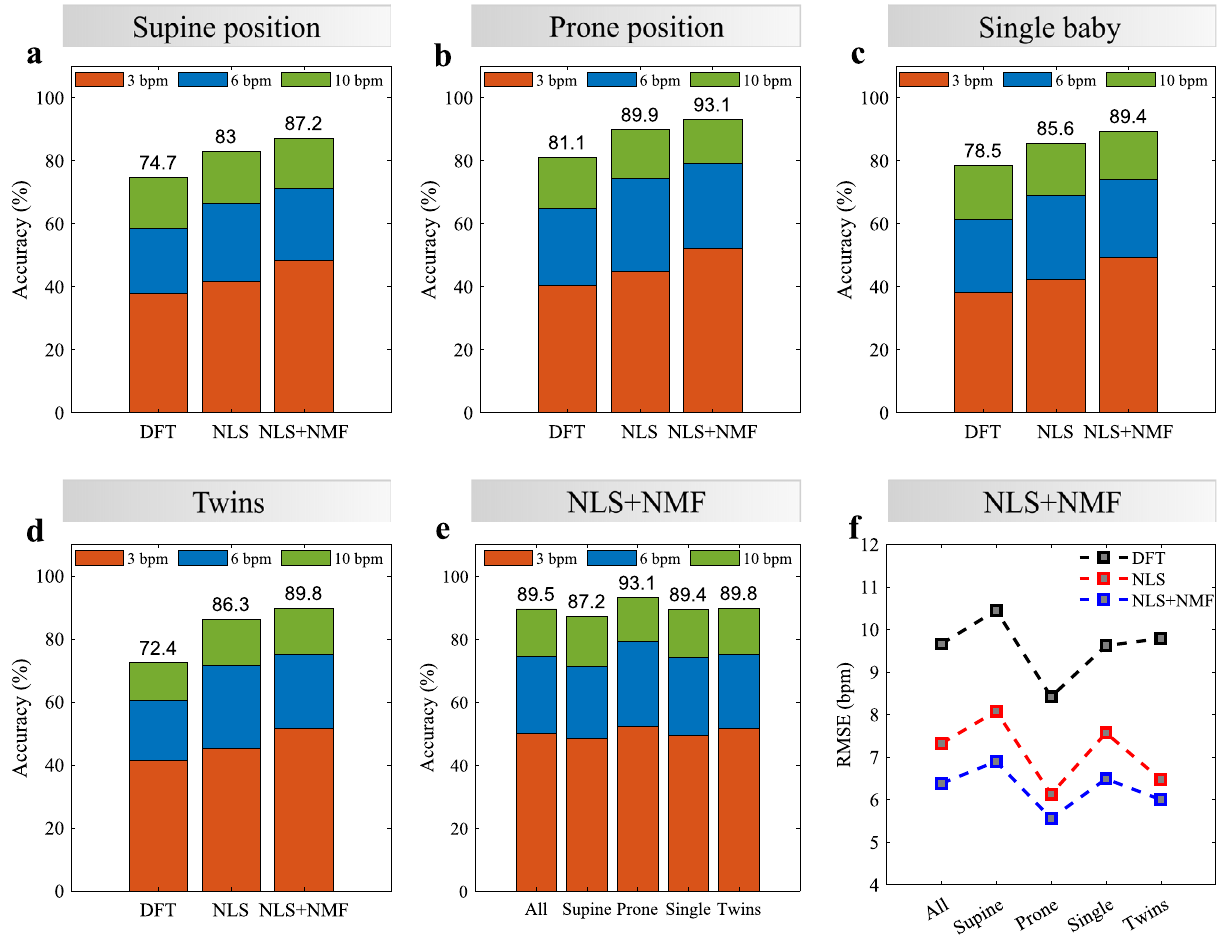
Figure 6. Summary of results, considering all processed sequences for each scenario, and comparing different techniques: standard DFT estimation (DFT), the proposed NLS estimation (NLS), and the complete proposed solution, with RBM mitigation (NLS+NMF). Average accuracy for different techniques. ( a ) Supine position. ( b ) Prone position. ( c ) Single infant in the cot. ( d ) Twins sharing the cot. ( e ) Average accuracy for different scenarios, considering the complete proposed solution (NLS+NMF). ( f ) Average RMSE for different scenarios and different